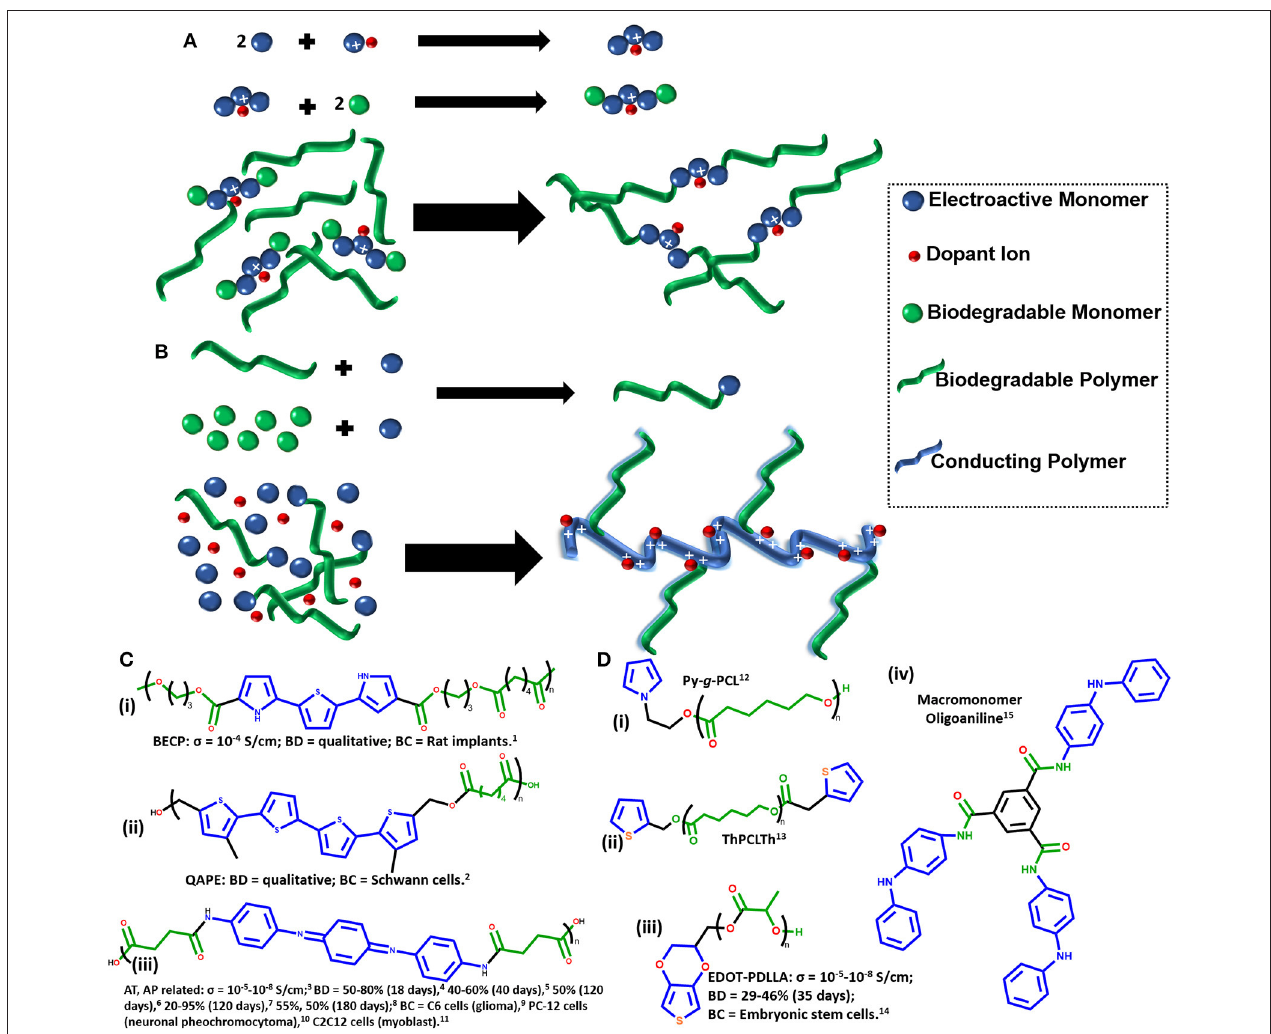
FIGURE 1 | (A) Schematic synthesis of electroactive oligomers and block copolymers. (B) Schematic synthesis of electroactive macromonomers and graft copolymers. (C) Chemical structure of electroactive and biodegradable oligomers. (D) Chemical structure of electroactive and biodegradable macromonomers. The σ is conductivity, BD is biodegradability and BC is biocompatibility. Blue color represents the conductive/electroactive molecules and green color represents the biodegradable molecules. The conductivity, biodegradability, and biocompatibility parameters are only reported for studies which aimed use the synthesized materials for biomedical applications. 1 ( Rivers et al., 2002), 2 (Guimard et al., 2009), 3 (Ding et al., 2007; Huang et al., 2007, 2008; Guo et al., 2011d, 2012; Zhao et al., 2017), 4 (Zhao et al., 2017), 5 (Wang et al., 2015), 6 (Ding et al., 2007), 7 (Xie et al., 2015a), 8 (Huang et al., 2008), 9 (Huang et al., 2007), 10 (Huang et al., 2008),